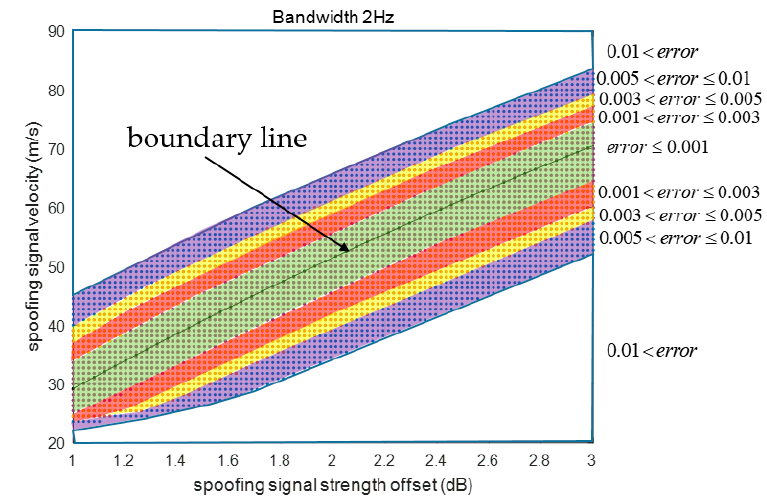
Figure 16. SPE error according to spoofing signal strength and velocity.